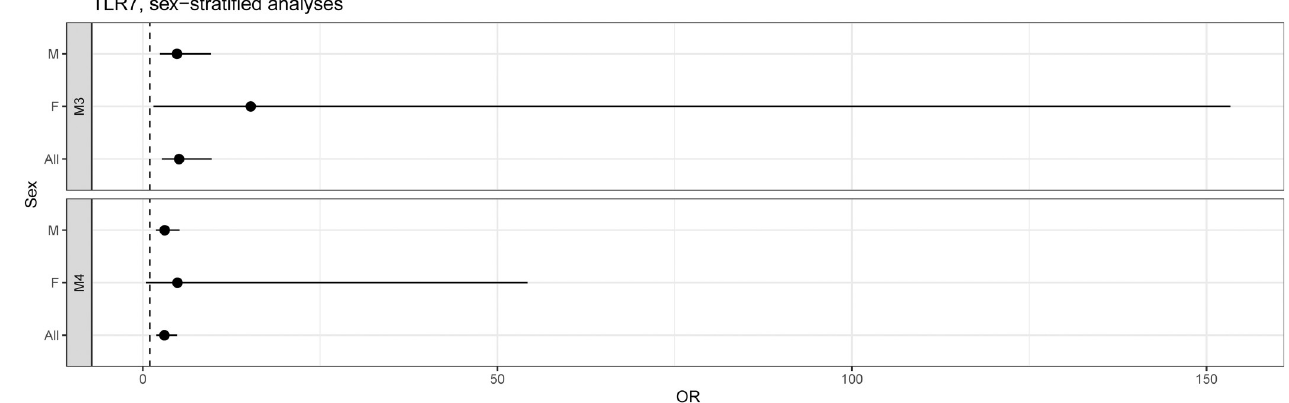
Fig 5. Sex-stratified TLR7 analyses.